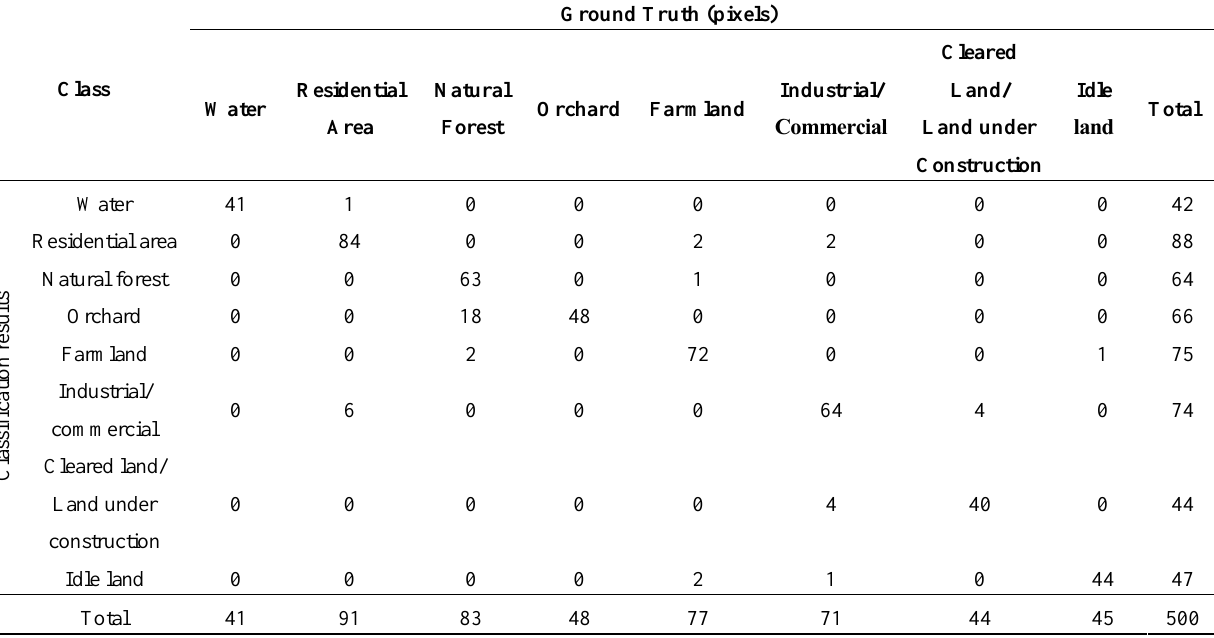
Table 7. The confusion matrix of the best